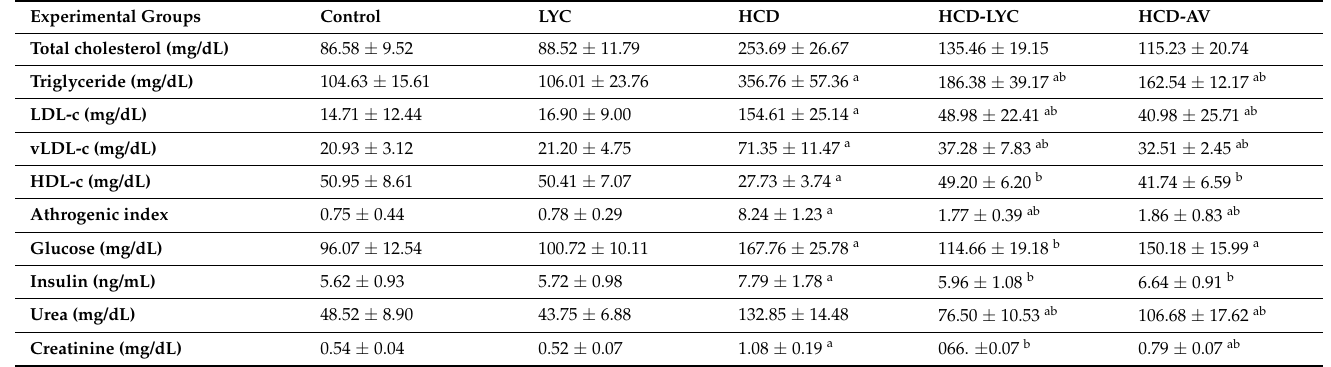
Table 2. Effects of dietary cholesterol and lycopene on serum glycemic features, lipid profile, and kidney function parameters in rats over 12